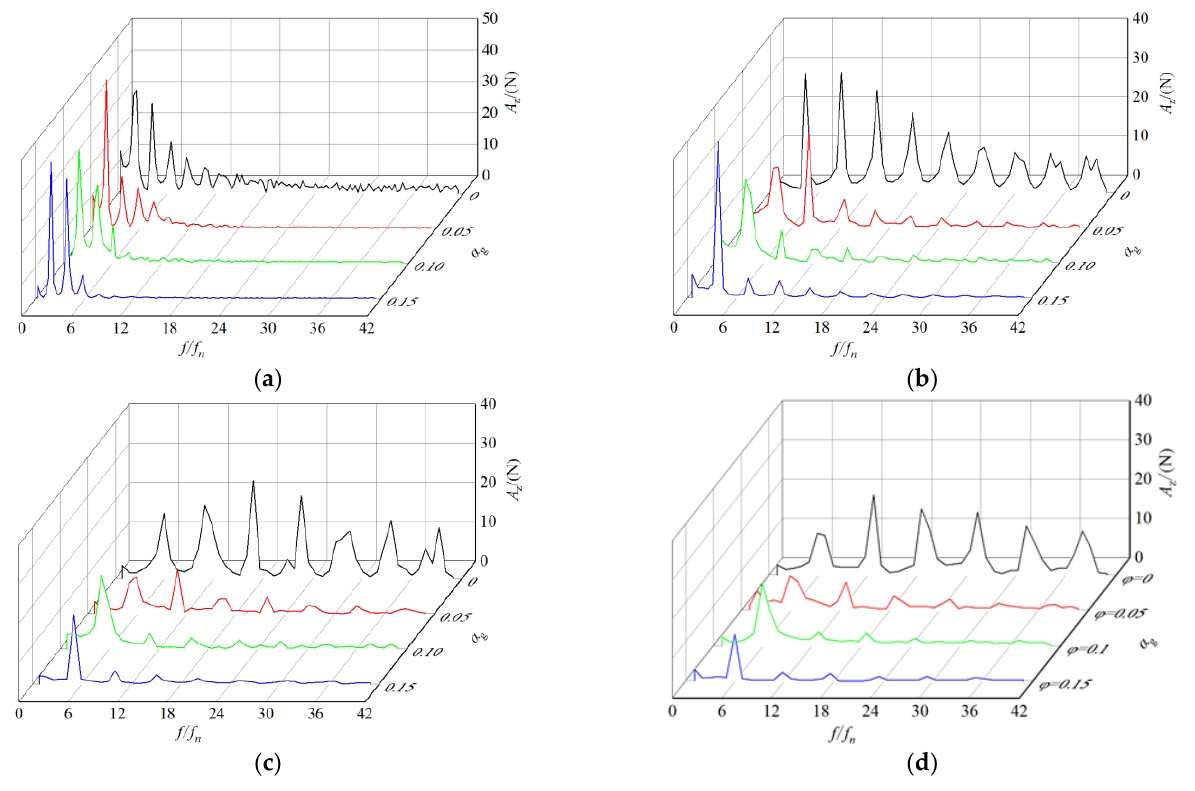
Figure 15. Frequency domain characteristic of axial force pulsation during the start-up process. ( a ) t = 1 s; ( b ) t = 2 s; ( c ) t = 3 s; ( d ) t = 4